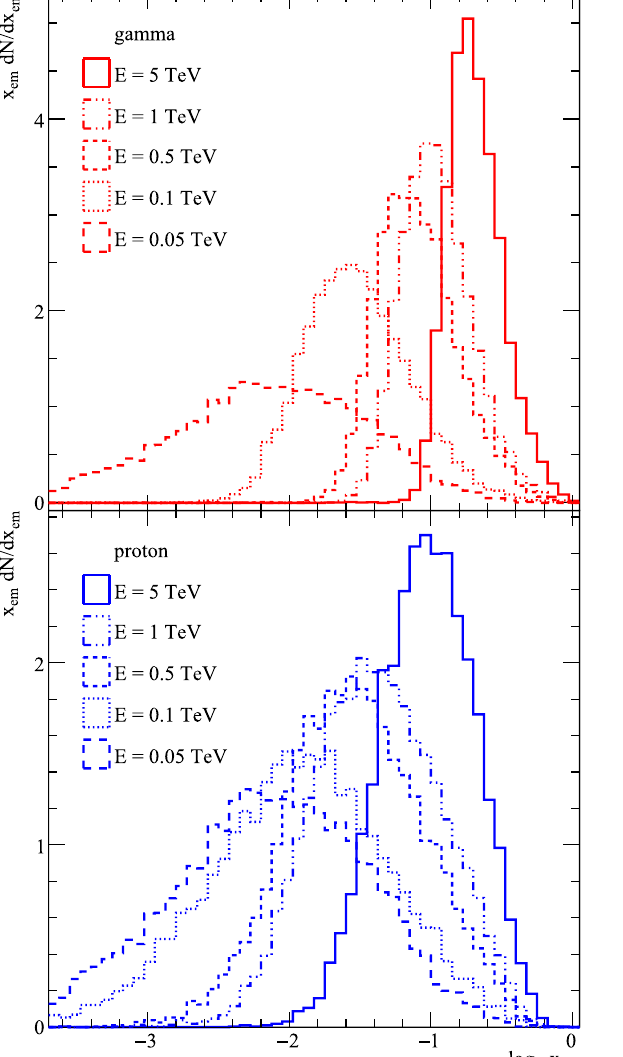
Fig. 4 Distributions of the electromagnetic energy that reaches the ground at 5 km altitude for vertical showers, expressed as a fraction of the primary particle energy x em = E em / E . γ -ray initiated showers are shown in the top panel and protons in the bottom panel